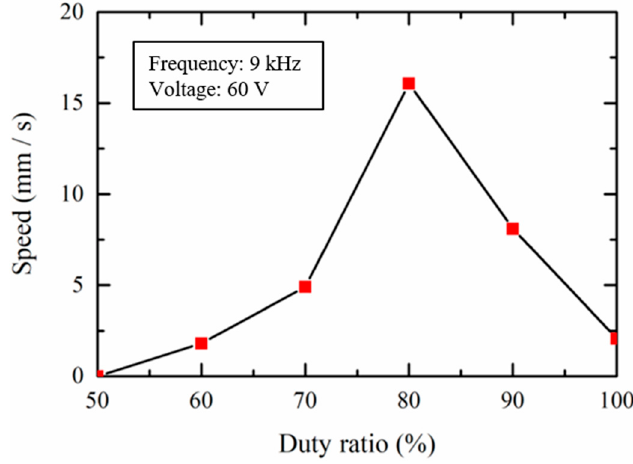
Figure 16. Driving characteristics of the slider 2 at different duty ratios.